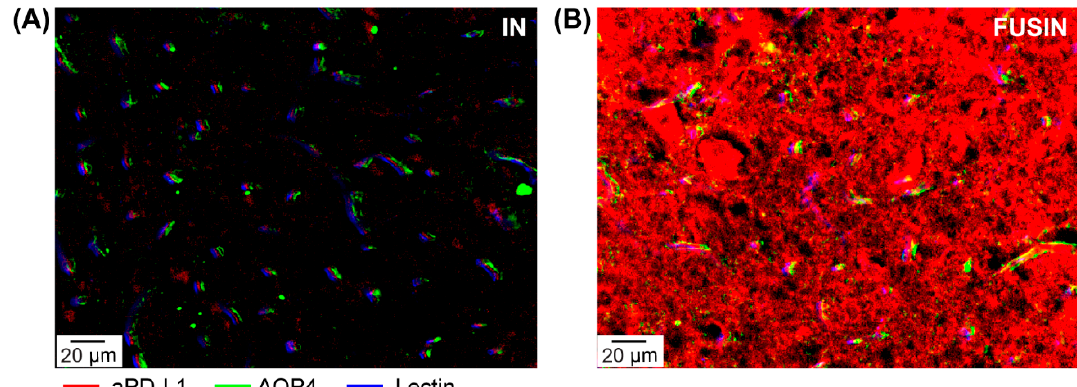
Figure 3. Fluorescence images of the brainstem obtained from non-tumor mice after intranasal (IN) ( A ) and FUSIN ( B ) delivery. After IN delivery, immunofluorescence staining shows the aPD-L1 distributed along with the perivascular spaces, defined by the space between the AQP4-stained astrocyte and the lectin-stained blood vessel. FUSIN enhanced the accumulation of aPD-L1, and the delivered aPD-L1 penetrated deep into the brain parenchyma.